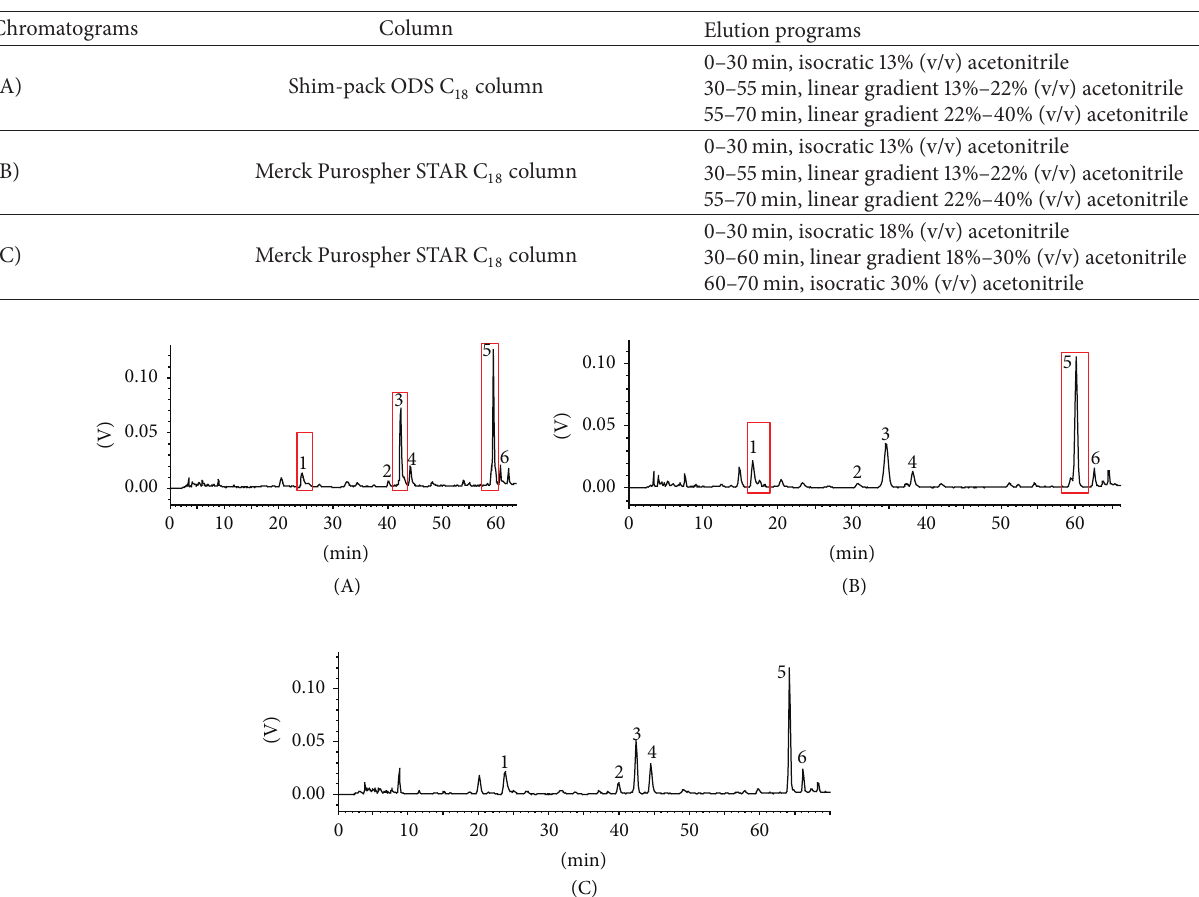
Table 1: The different separation system (see Figure 2).